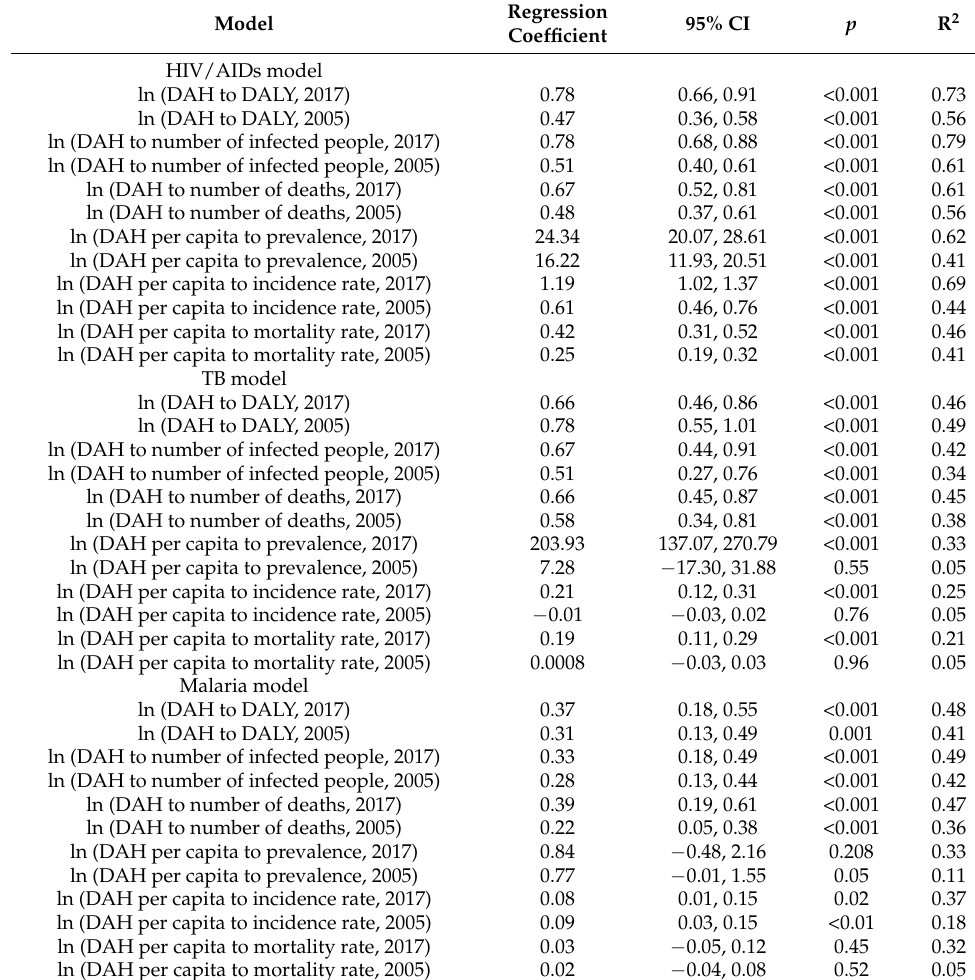
Table 2. Associations between development assistance for health and disease burden (in 2005 and 2017) *. Model